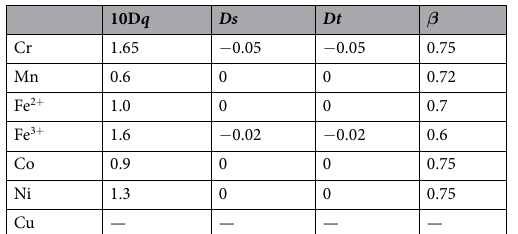
— — Table 2. Shown are the crystal field parameters for the calculations in pink in Fig. 4. The units for 10 Dq , Ds , and Dt are eV, while β is unitless and corresponds to the scaling of the interatomic Slater